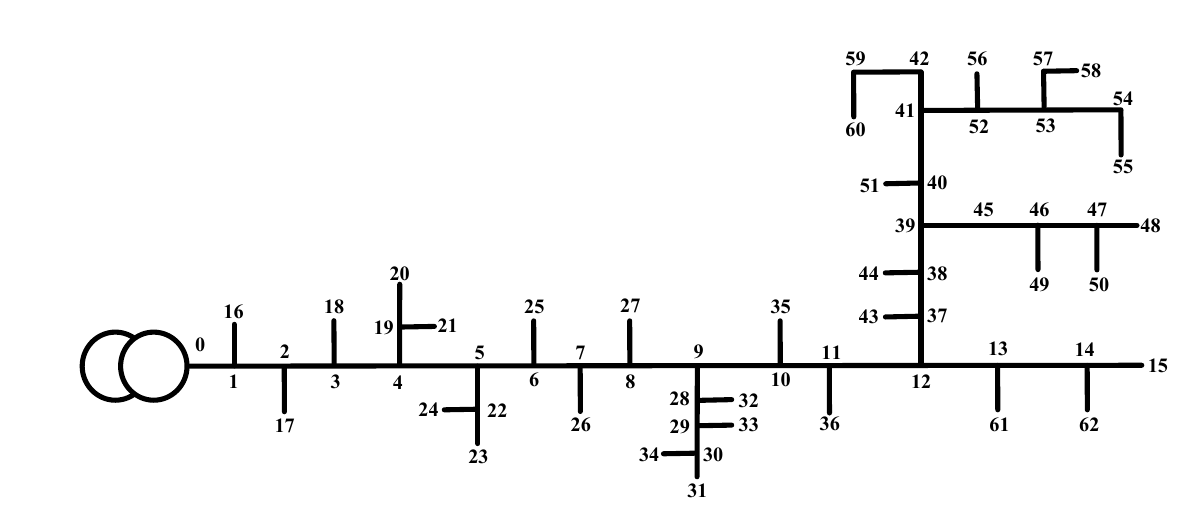
Figure 4. Modified IEEE 62 nodes distribution network structure. Table 2. The list of basic parameters. Price (Yuan/kWh) 0.4816 DG unit price (yuan/kW) 2400 The annual average cost of fixed investment coefficient 0.35 The maximum number of access DG (a) 62 Reference voltage (kV) 10 The maximum loss of load hours (h) 3000 Using the maximum load in hours (h) 3000 DG Power Factor 0.9 Node voltage, current leads, DG injection amount penalty factor